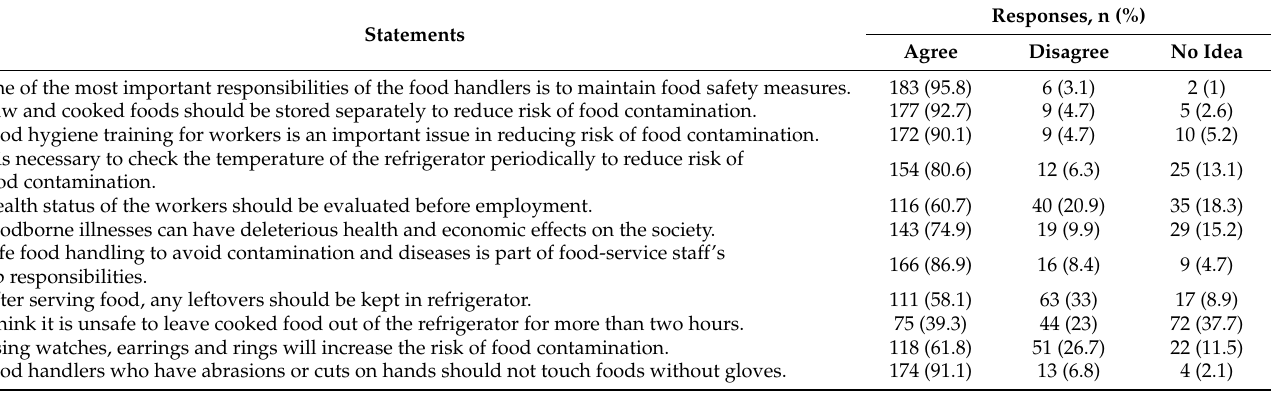
Table 3. Summary of questions and responses for assessment of food safety attitudes of food handlers working at hospitals in Bangladesh (N = 191).